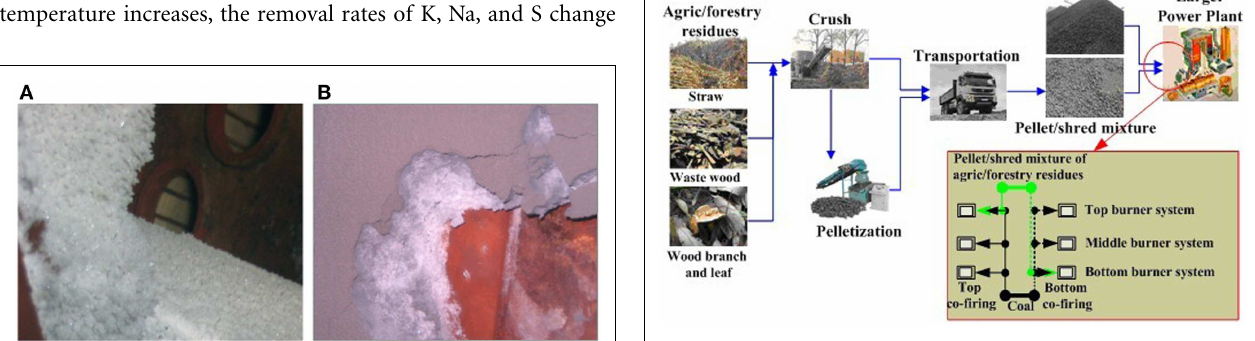
FIGURE 4 | NH 4 Cl in the boiler . (A) Slag location. (B) Slag thickness.